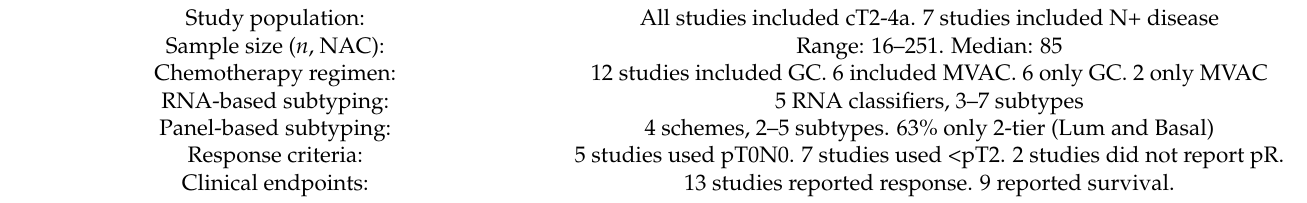
Table 3. Sources of variability in experimental design between the 14 included